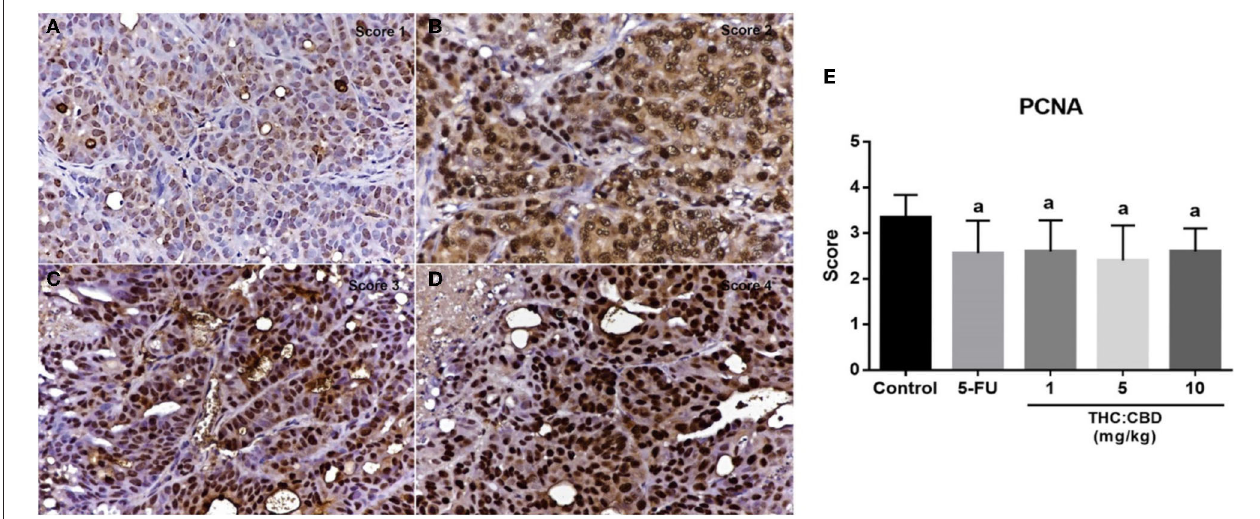
FIGURE 6 | The expression score of PCNA in tumor (A) score = 1, (B) score = 2, (C) score = 3, and (D) score = 4 (counterstained with Mayer’s hematoxylin, 40 × ). The graph demonstrates the expression score of PCNA in the negative control group, the positive control group (5-FU), and THC:CBD at the dose of 1, 5, and 10 mg/kg BW. Data were expressed as mean ± SD. a indicates a significant difference at P < 0.05 compared to the negative control group (E) .